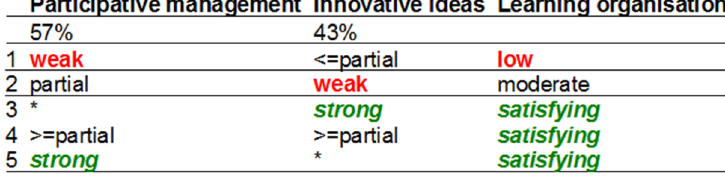
Figure A4. Utility function of the aggregated attribute learning organization.